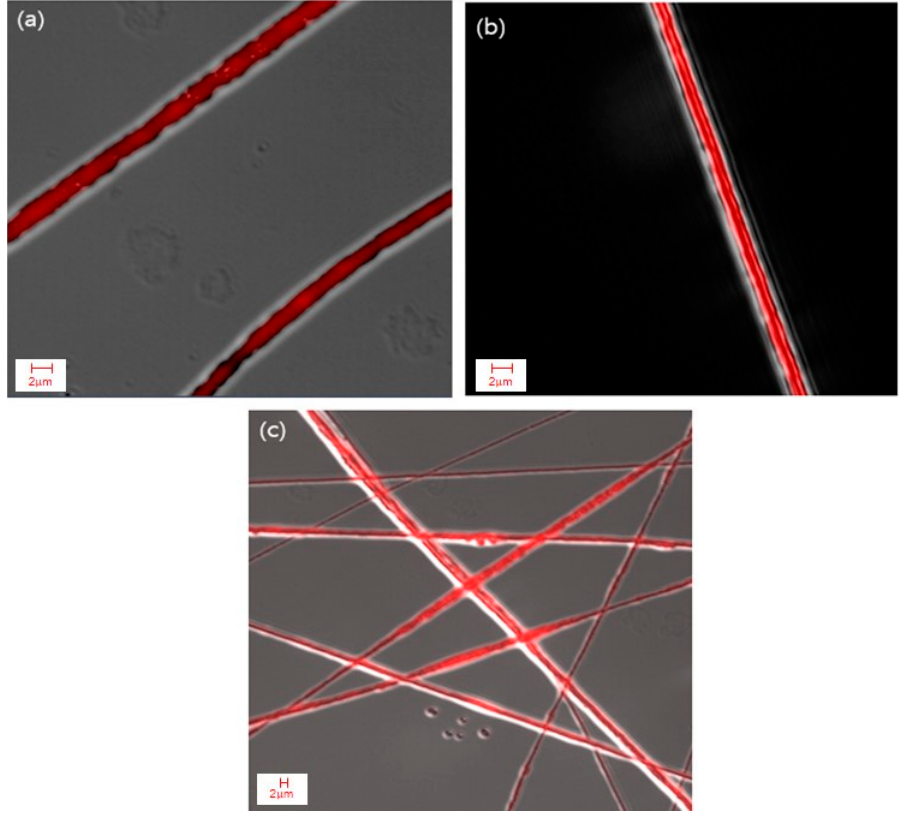
Figure 7. CLSM images of cinnamon oil/PVA nanofibers from emulsion H: ( a – c ) core/sheath structures of cinnamon oil/PVA nanofibers.